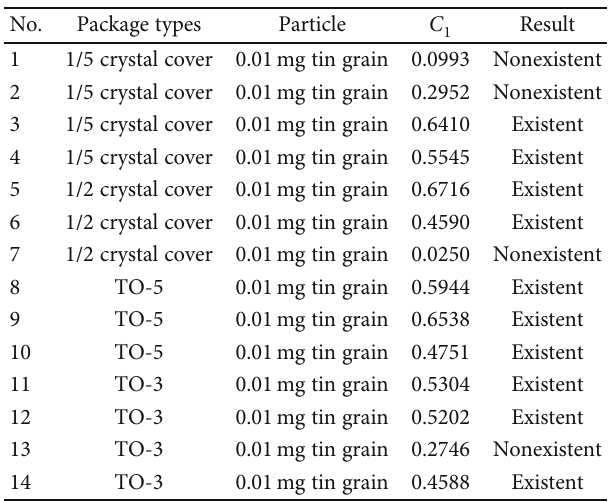
Table 1: The cross-correlation coe ffi cient was received by averaging 100